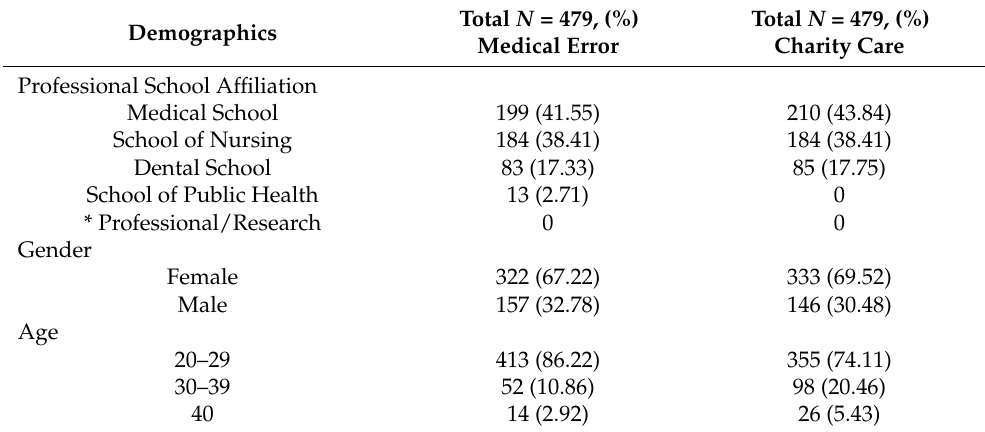
Table 1. Demographics of students participating two in-person simulations from August 2019–May 2020. ( N = 958